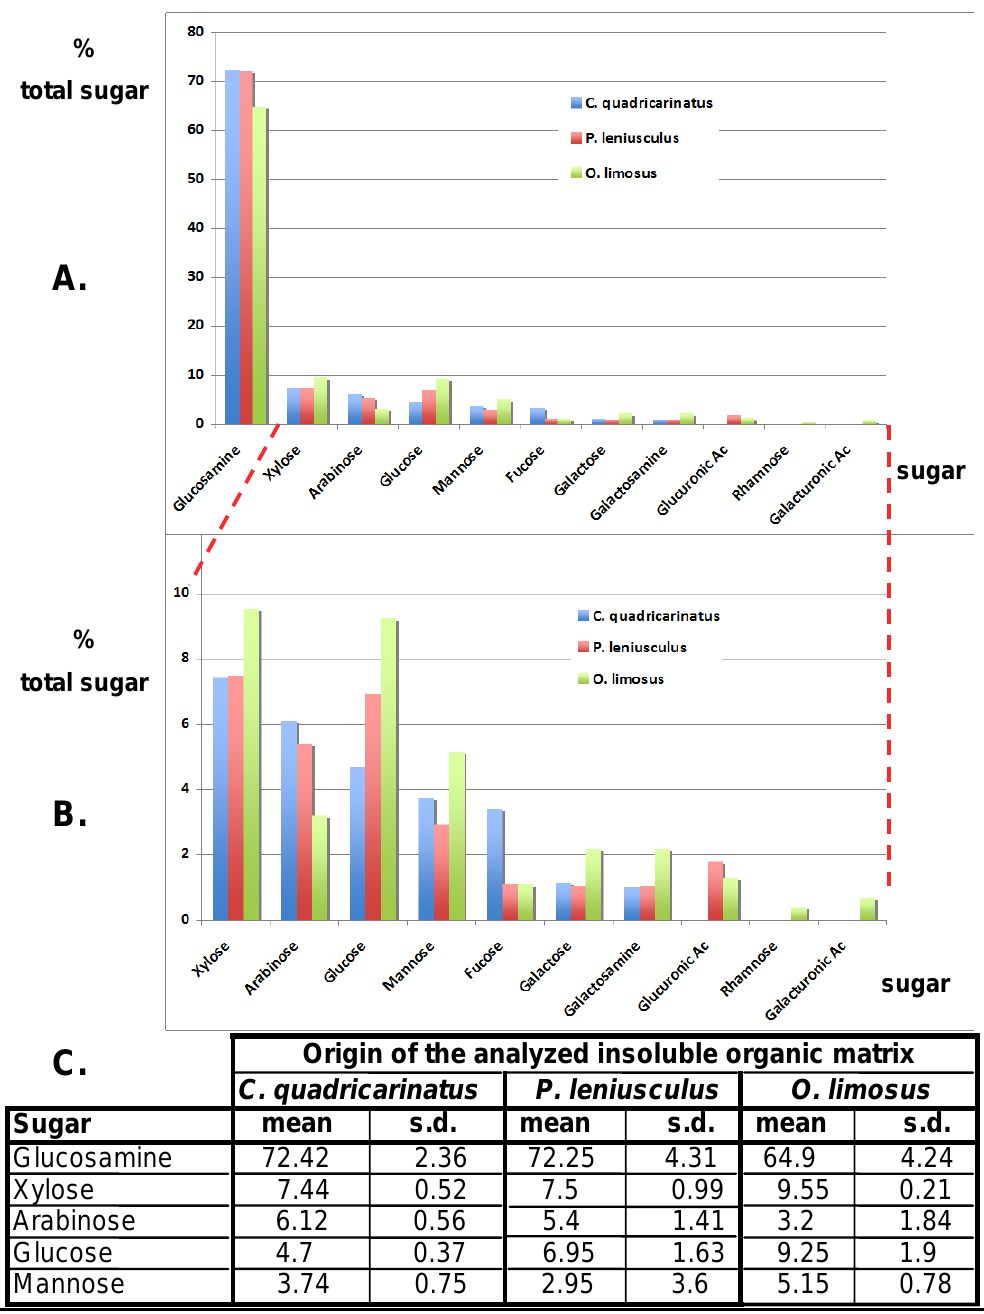
Table 1. Relative distribution of monosaccharides in the acid insoluble gastrolith organic matrix from three crayfish species determined by high performance anion-exchange chromatography after trifluoracetic acid (TFA) hydrolysis. A. Diagram representation of the monosaccharides distribution in Cherax quadricarinatus (blue), Pacifastacus leniusculus (red), Orconectes limosus , (green). B . Enhanced diagram representation of the minor monosaccharides (scale of the y-axis: from 0 to 10%). C. Amount of the main monosaccharides (expressed in % total sugar; mean ± sd from three analyses).